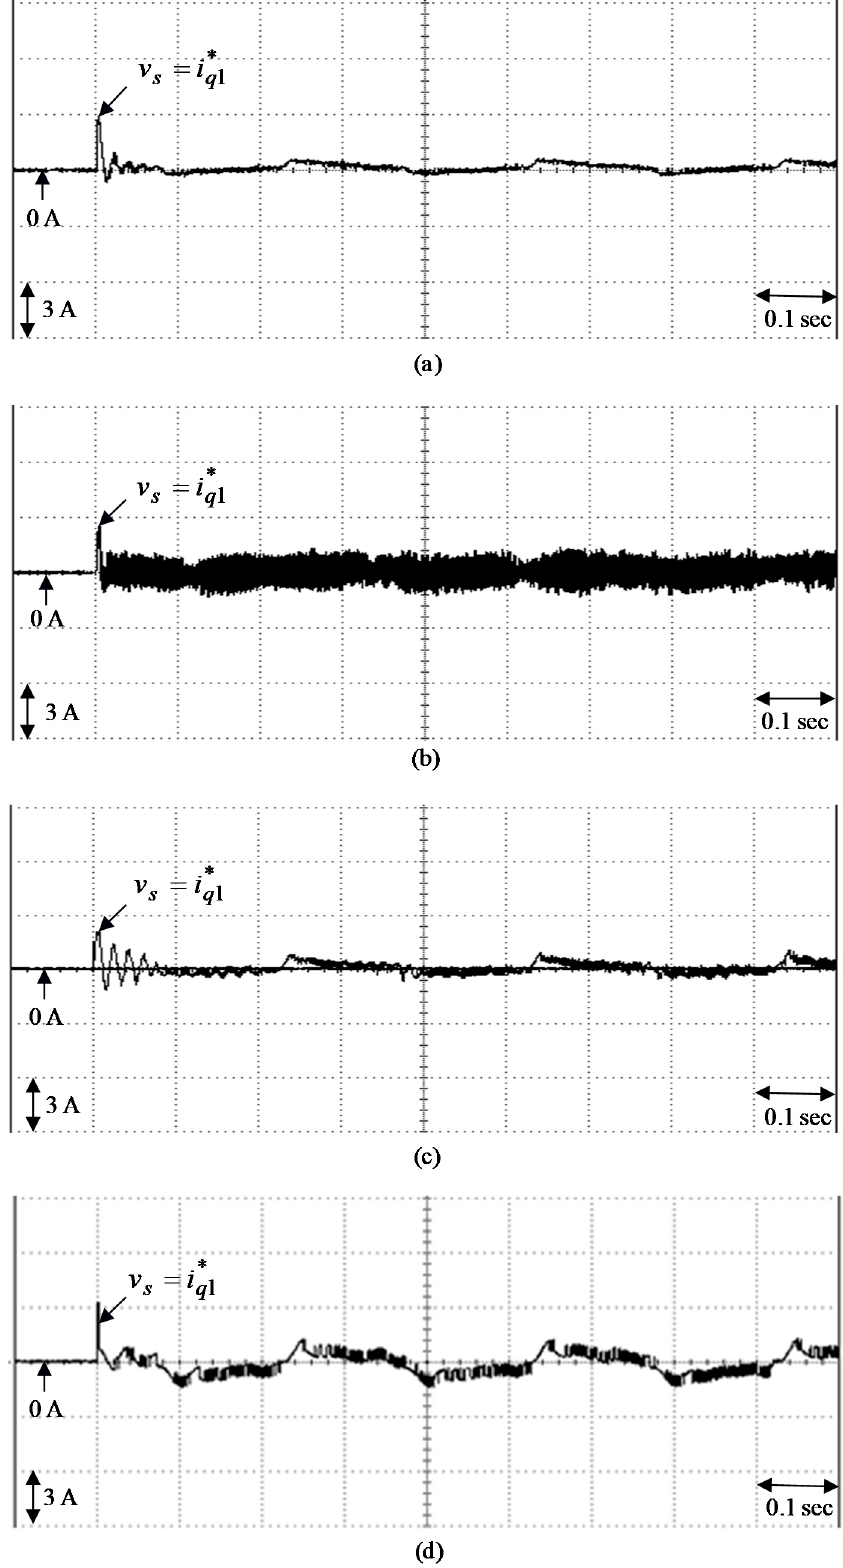
Figure 13. Experimental results of the response of control propulsion in Case R3 ( a ) by utilizing control system W1, ( b ) W2, ( c ) W3, and ( d ) W4.